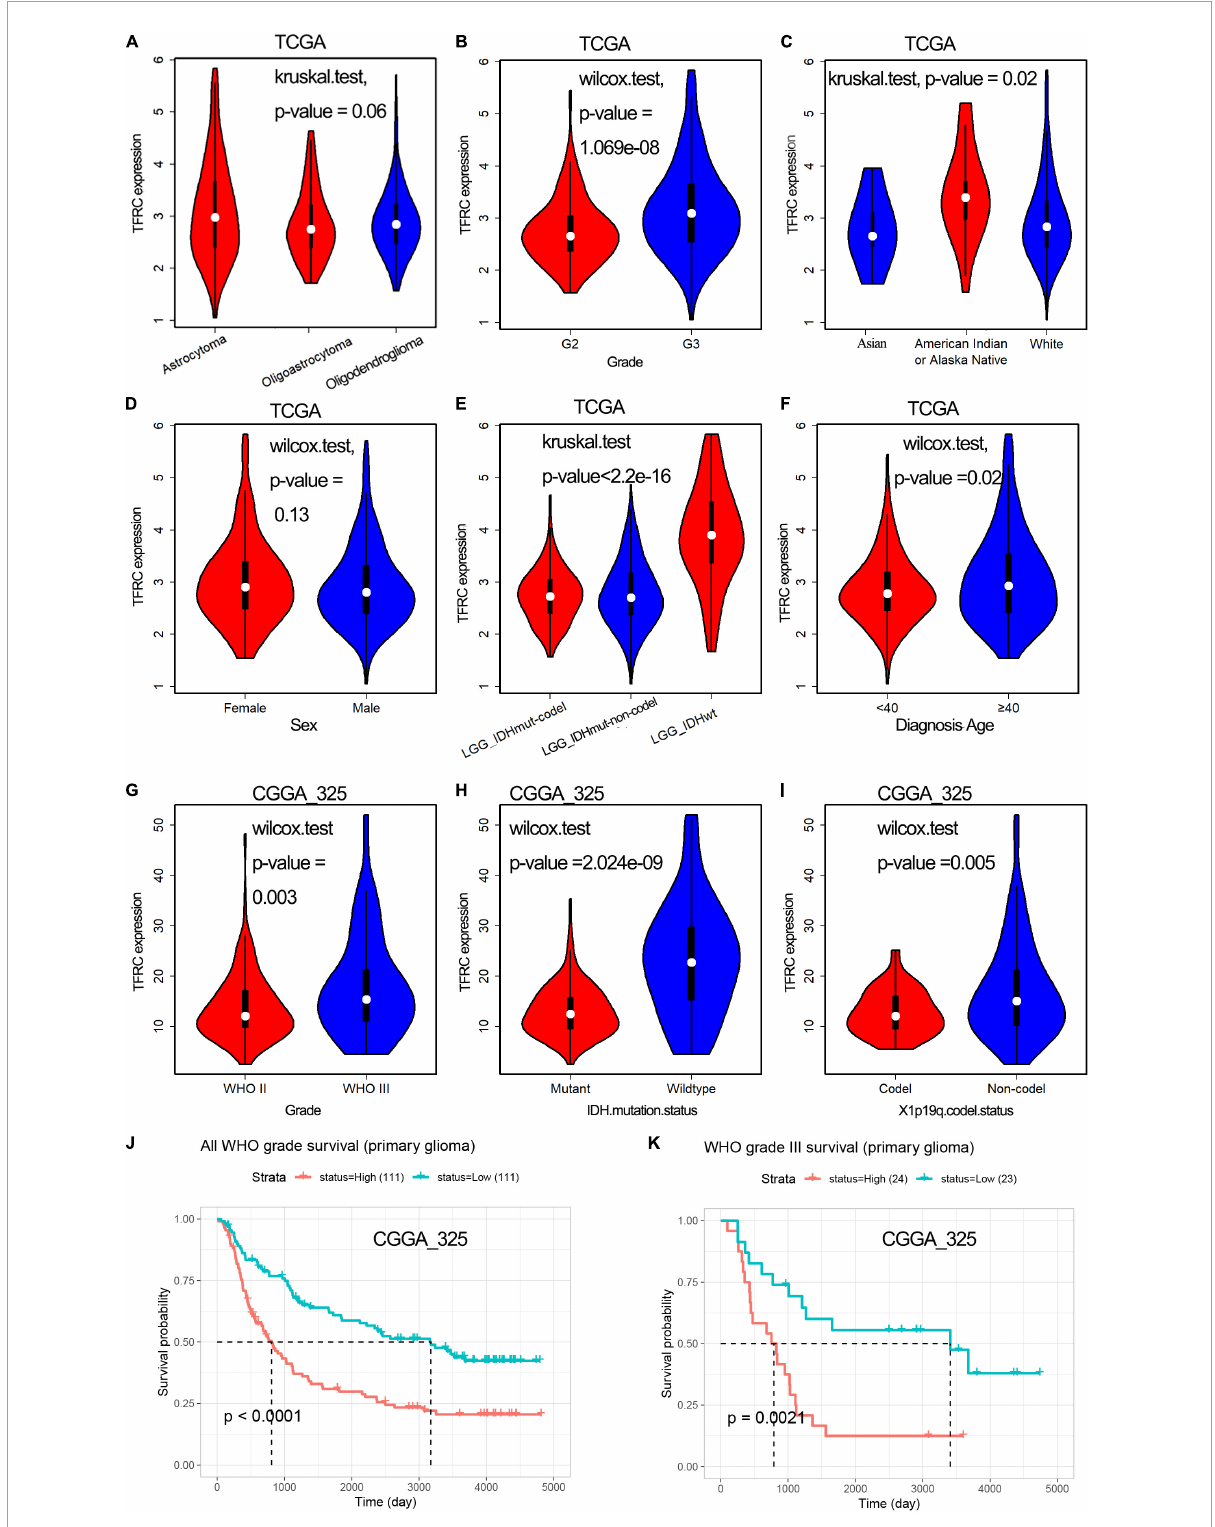
FIGURE2 Relationship between TFRC expression and clinicopathologic variables of patients with LGG and OS analysis. (A–F) Histopathologic classification (A) , histology grade (B) , race (C) , sex (D) , IDH mutation status (E) , and diagnosis age (F) in TCGA. (G–I) Histology grade (G) , IDH mutation status (H) , chromosomal 1p/19q codeletions (I) in CGGA. (J,K) Association with TFRC expression and overall survival